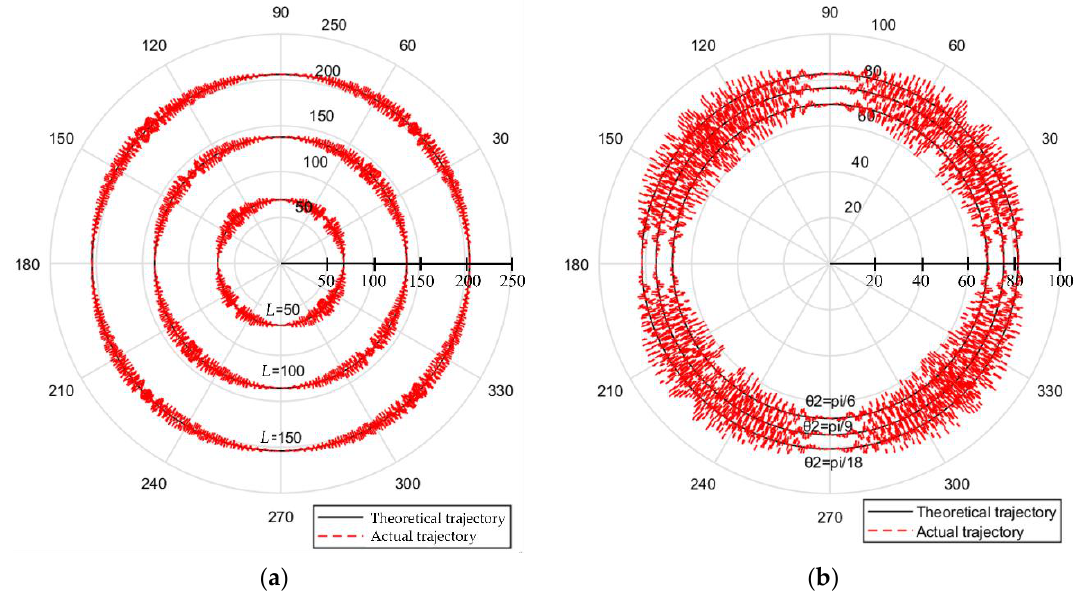
Figure 7. Simulation results of the influence of the noise of measurement device on the circular motion trajectory of machine tool. ( a ) The result under different bar lengths. ( b ) The result under different pose angles.